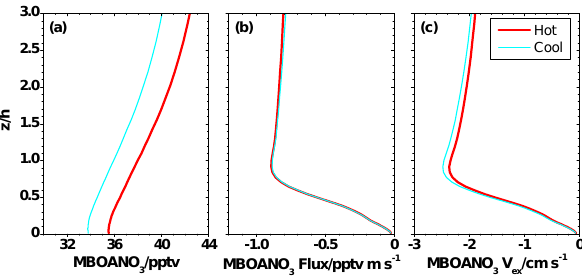
Fig. 10. Vertical profiles of (a) mixing ratios, (b) fluxes and (c) exchange velocities for MBOANO 3 . Model results are shown for both hot and cool